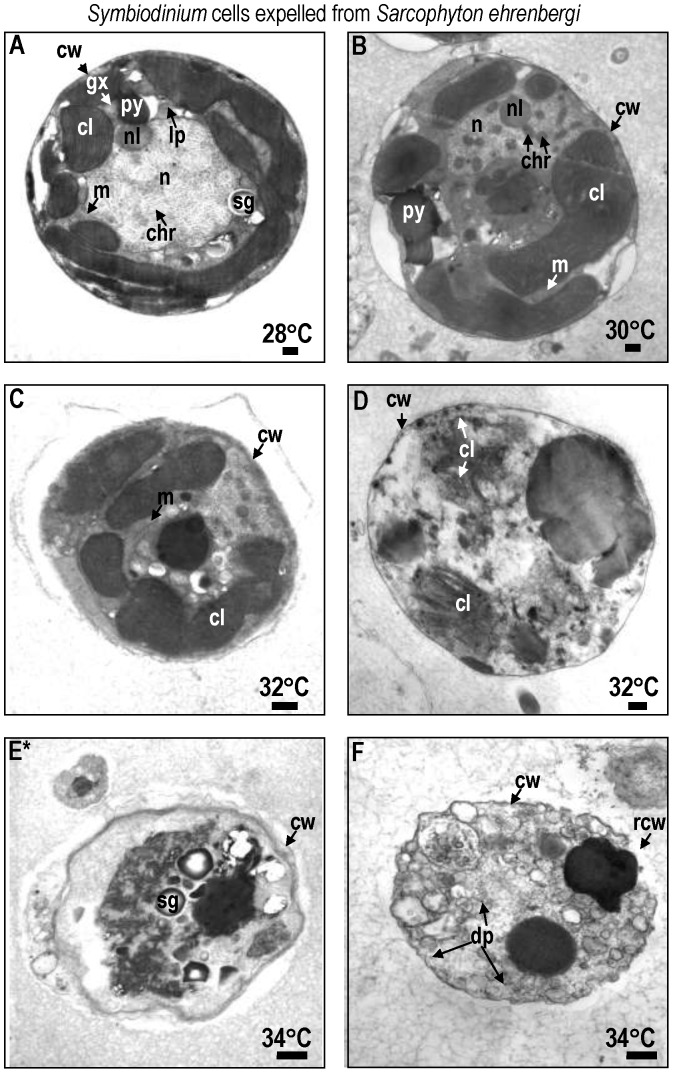
Transmission Electron Micrograph (TEM) of Symbiodinium cells lost from Sarcophyton ehrenbergi at temperatures 28 to 34°C.Most Symbiodinium cells appeared normal at 28 to 30°C (A,B). Symptoms of reversible early- to mid-stage apoptosis (C) or necrosis (D) occurred at 32°C within 12 h. After 9 h at 34°C, many Symbiodinium cells exhibited symptoms of late non-reversible apoptosis (E) and necrosis (F). Symbols: ab = apoptotic body, chr = chromosome, cl = chloroplast, cw = cell wall, gx = glyoxysome, m = mitochondria, n = nucleus, py = pyrenoid, sg = starch grain. Scale bar = 500 nm.